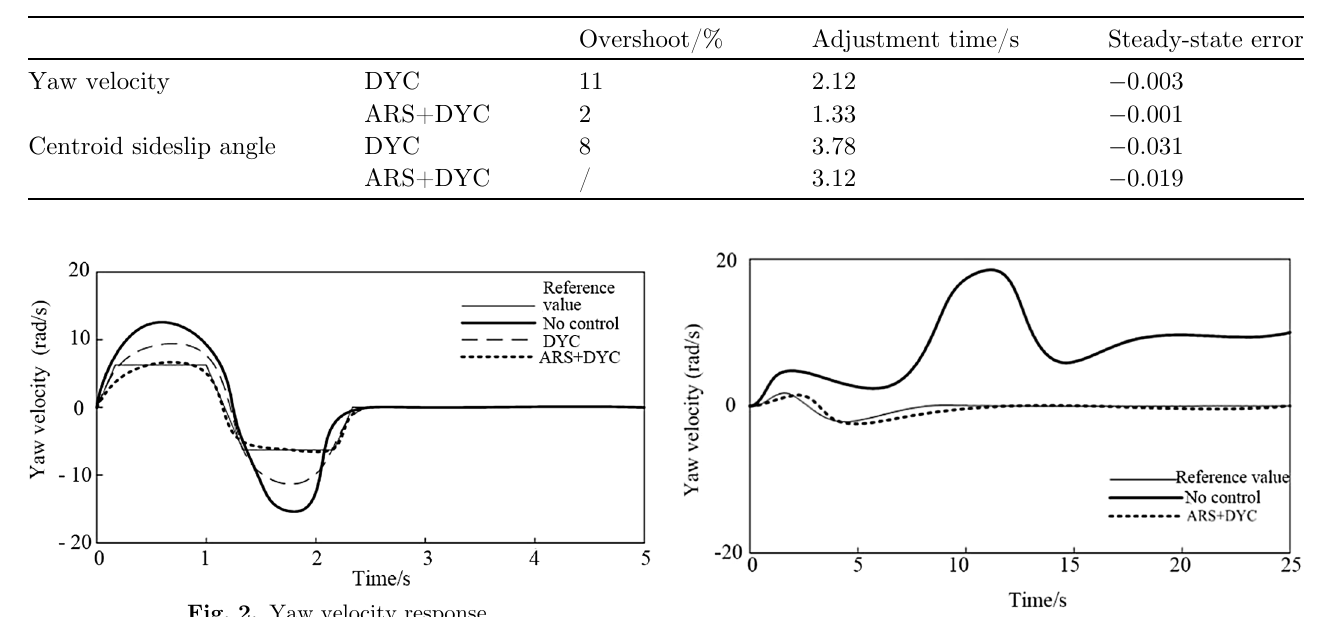
Fig. 5. Yaw velocity response.